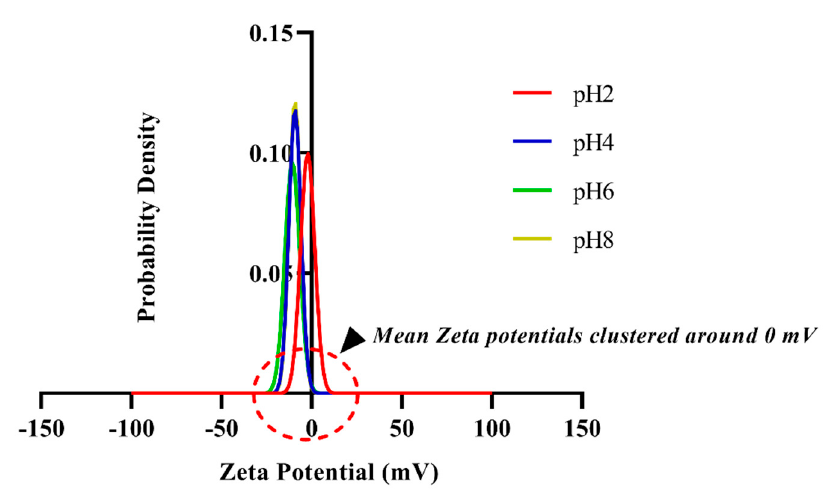
Figure 3. Probability density functions of zeta potential values for the entire physiologically relevant pH range (pH 2, 4, 6 and 8) measured in a human sweat analogue by the diffusion barrier method. Neutral or near-neutral behavior is evident from the clustering of the pdfs being 0 mV.